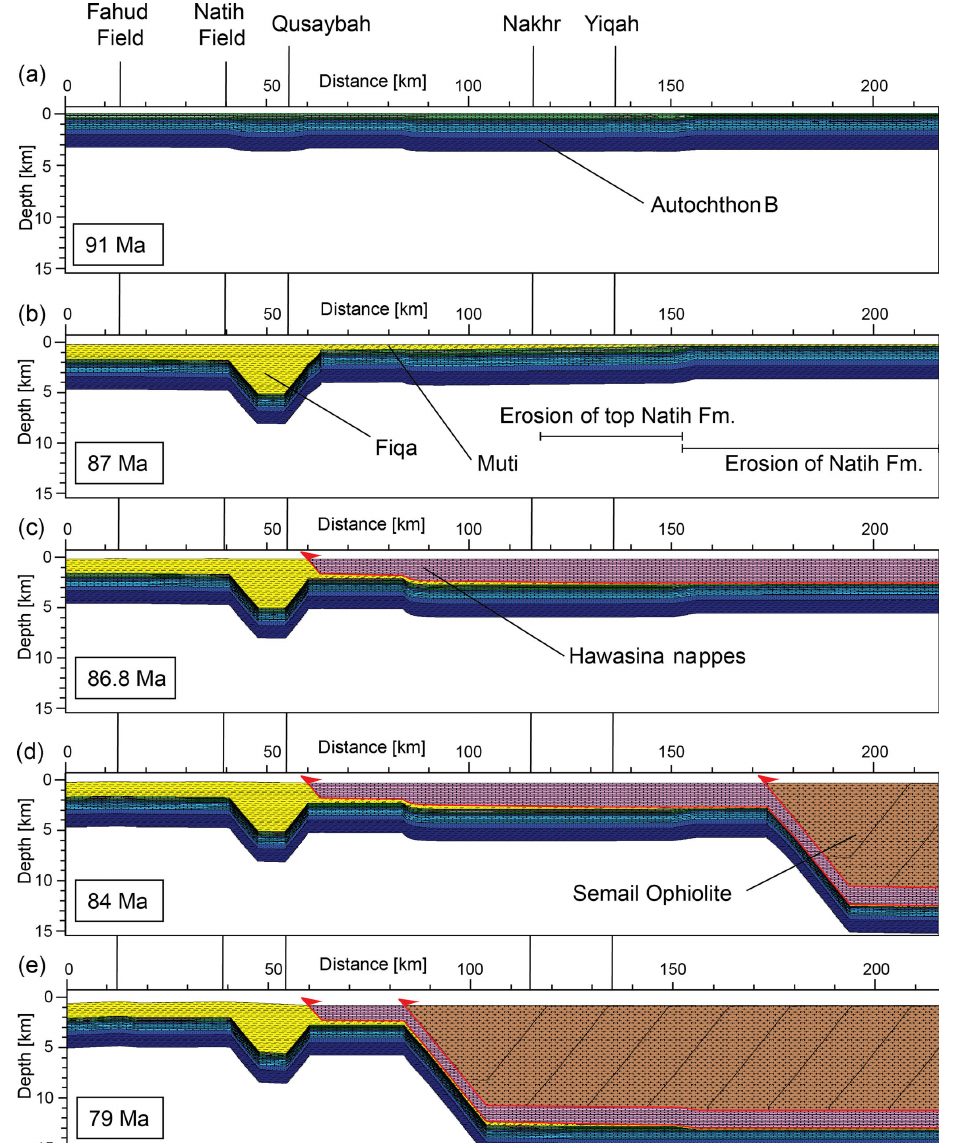
Figure 6. Modeling results: transect evolution from sedimentation of the Autochthon B at stable passive margin conditions (a) , moving foredeep that finally filled with Fiqa sediments ( b , peak burial as calibrated by thermal maturity data), Hawasina nappe (c) , and ophiolite emplacement (d) leading to deepest burial (e) . Highlighted with vertical lines in the background are the locations of present-day oil fields and sampled valley locations. Please note the unrealistically flat topography, which is a result of the modeling